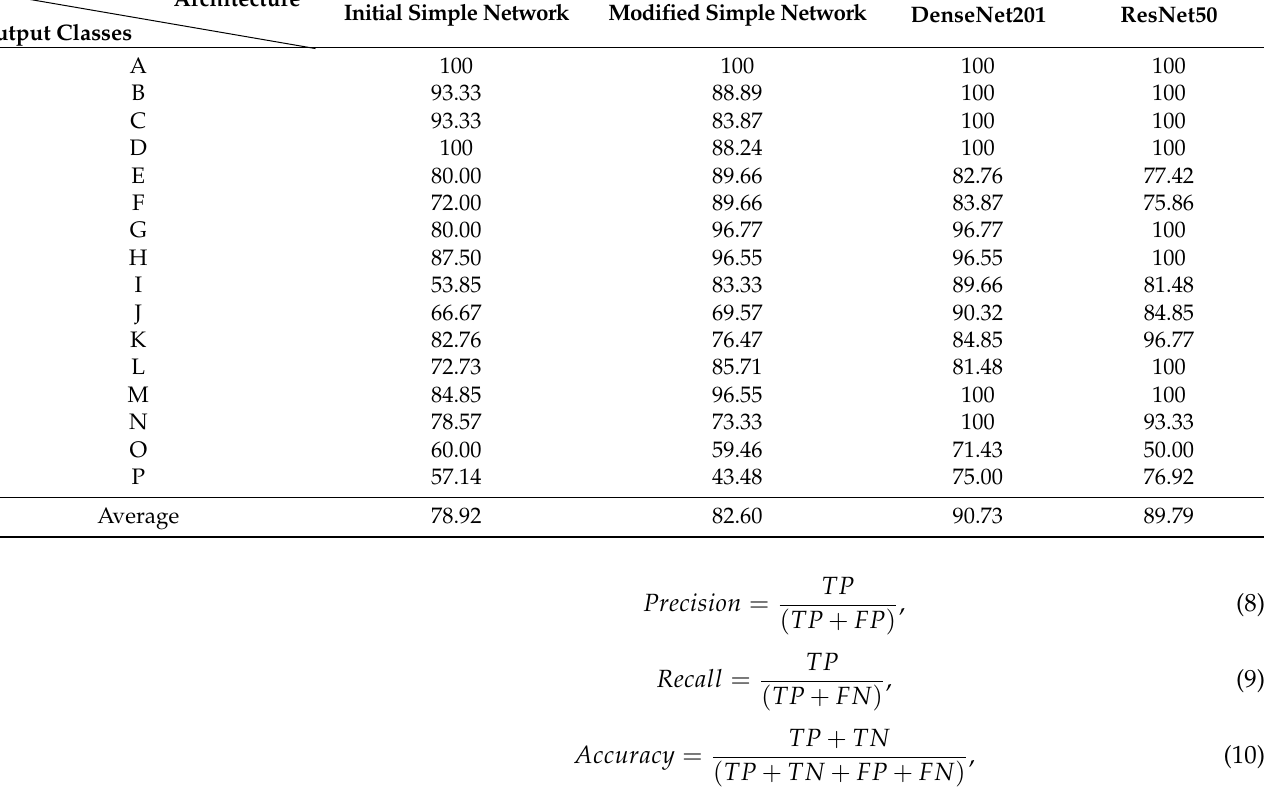
Table 10. Calculated F1 Score (%).